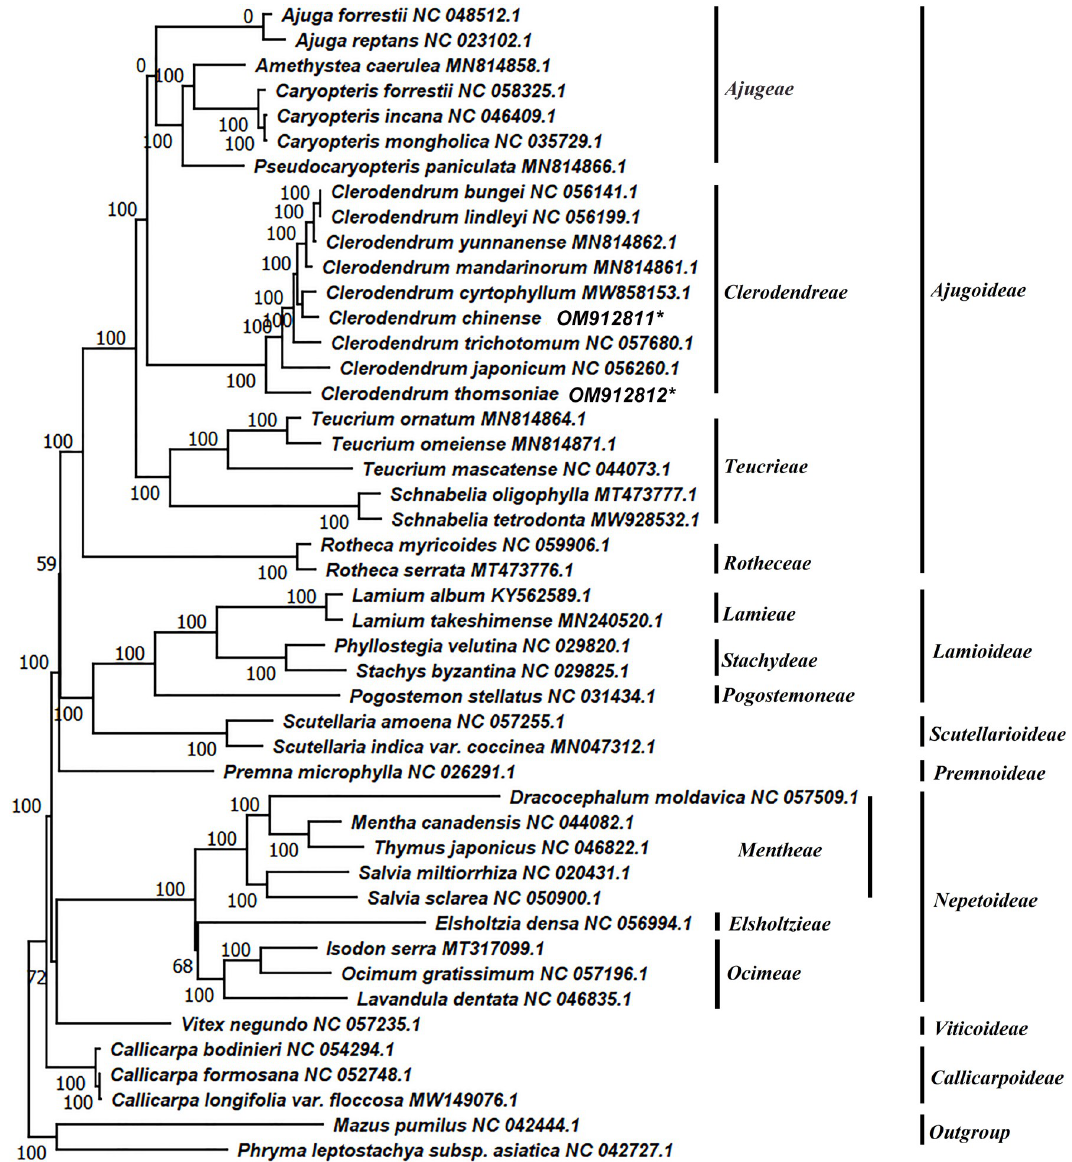
Fig 2. Evolutionary tree of family Lamiaceae. The phylogenetic results included 44 species within family and two out-group species. Mazus pumilus and Phryma leptostachya were set as the outgroups. The species marked with an asterisk are C . Chinense and C . thomsoniae , whose chloroplast genomes were firstly reported. The right of the panel is the name of tribe and subfamily according to the species. Numbers above the branches are the bootstrap support